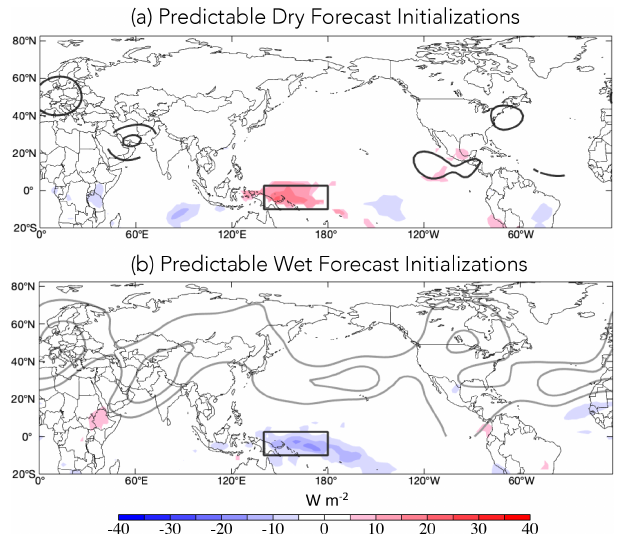
Figure 10. Composite OLR (color shading) and (cid:57) 200 (black- /gray contours) anomalies, during (a) high-expected-skill initializa- tions verified on anomalously dry days 18d later, N = 142d, and (b) high-expected-skill initializations verified on anomalously wet days 18d later, N = 163. The black contours show positive (anticy- clonic) streamfunction anomalies, and the gray contours show nega- tive (cyclonic) streamfunction anomalies, contoured at an interval of 3 × 10 6 m 2 s − 1 beginning at ± 3 × 10 6 m 2 s − 1 . Only anomalies that are statistically significant at the 95% confidence level are